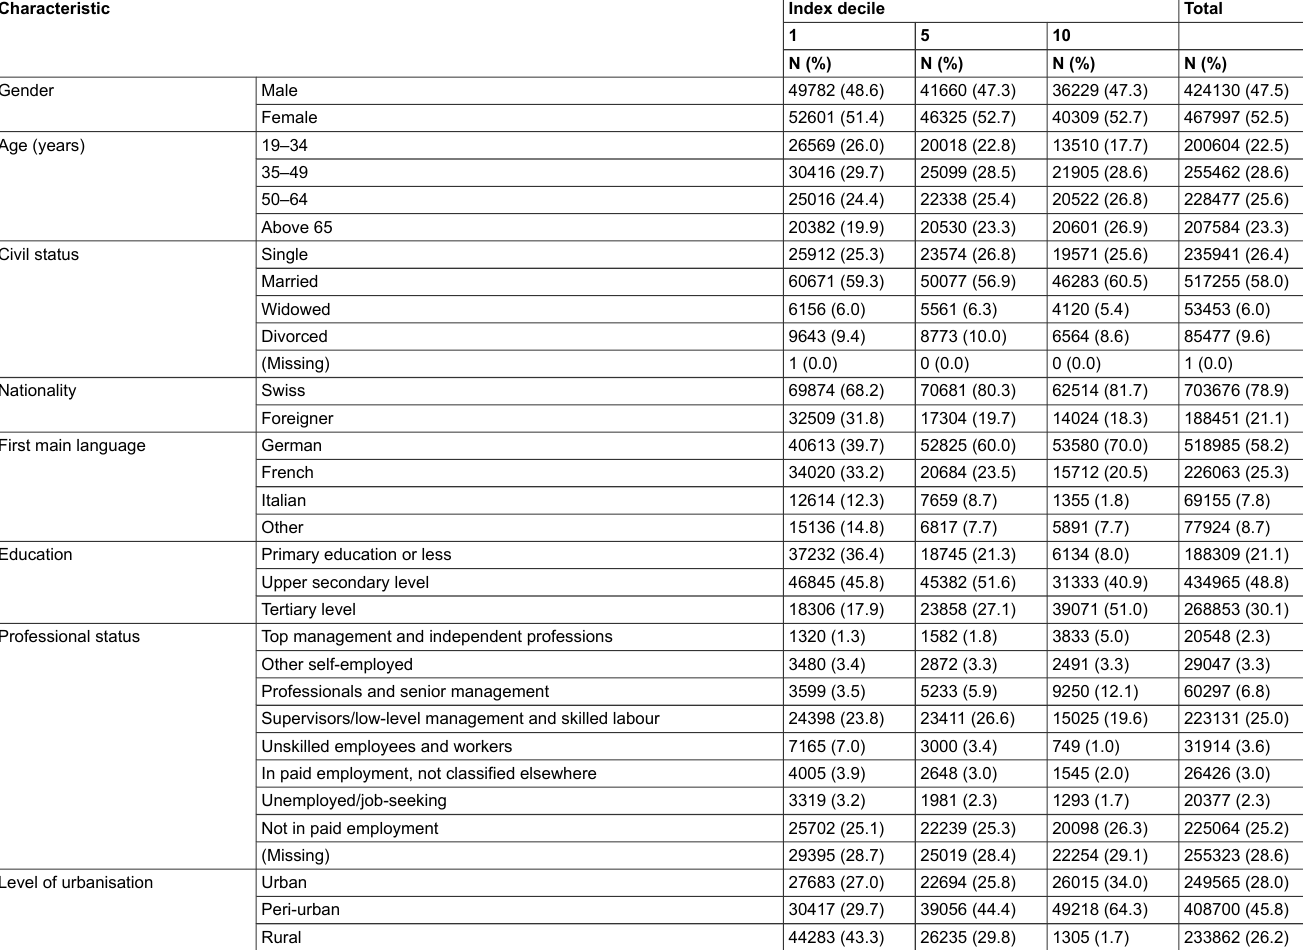
Table 1: Characteristics of the sample of the resident population in Switzerland across the first (lowest SEP), fifth and tenth (highest SEP) deciles of the hybrid version of the Swiss neighbourhood index of socioeconomic position (Swiss-SEP 3), Switzerland.